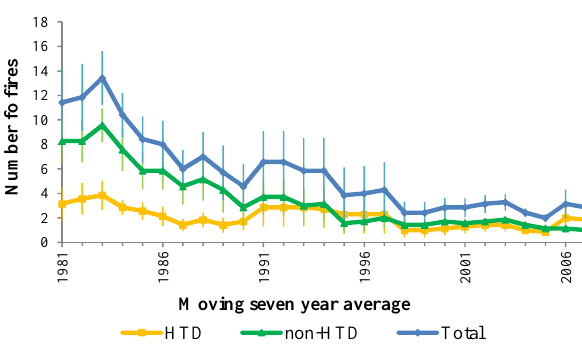
Fig. 3. Number of large wildland fires in Arag´on under high tem- Figure 3. Number of large wildland fires in Aragón under high temperature days (HTD), non2 perature days (HTDs), non-high-temperature days (non-HTDs) and high temperature days (non-HTD) and total number of large wildland fires (LWF) in Aragón3 total number of large wildland fires (LWFs) in Arag´on from 1978 to 2010. Moving seven-year average from 1981 to 2007. Vertical lines from 1978 to 2010. Moving seven-year average from 1981 to 2007. Vertical lines are the4 are the annual standard error values. annual standard error values.5